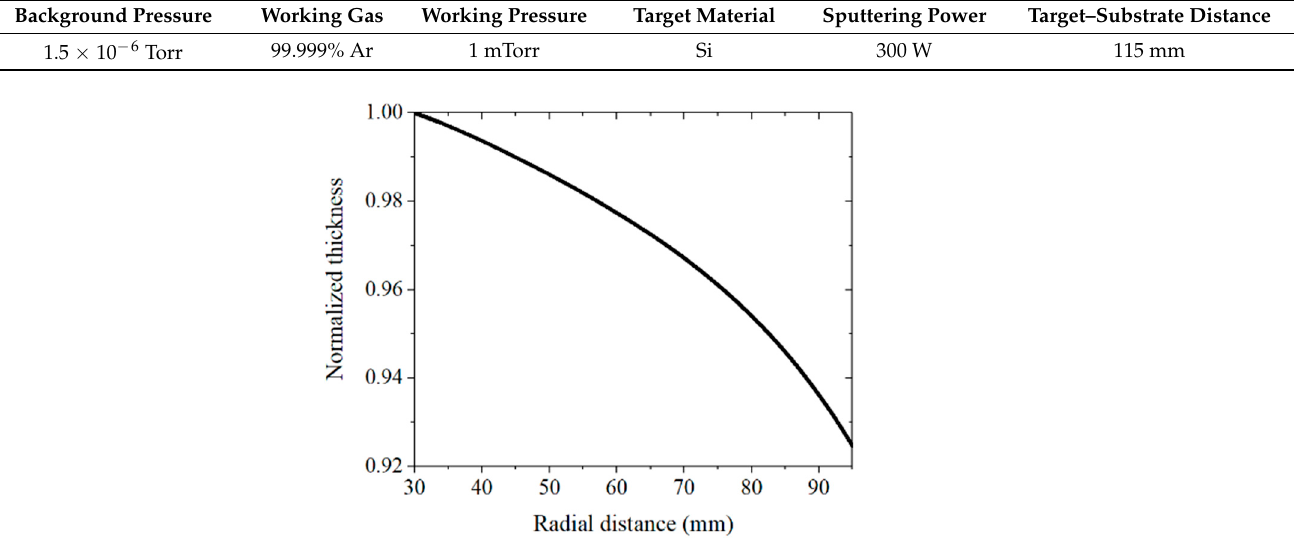
Figure 5. The radial film deposition distribution.